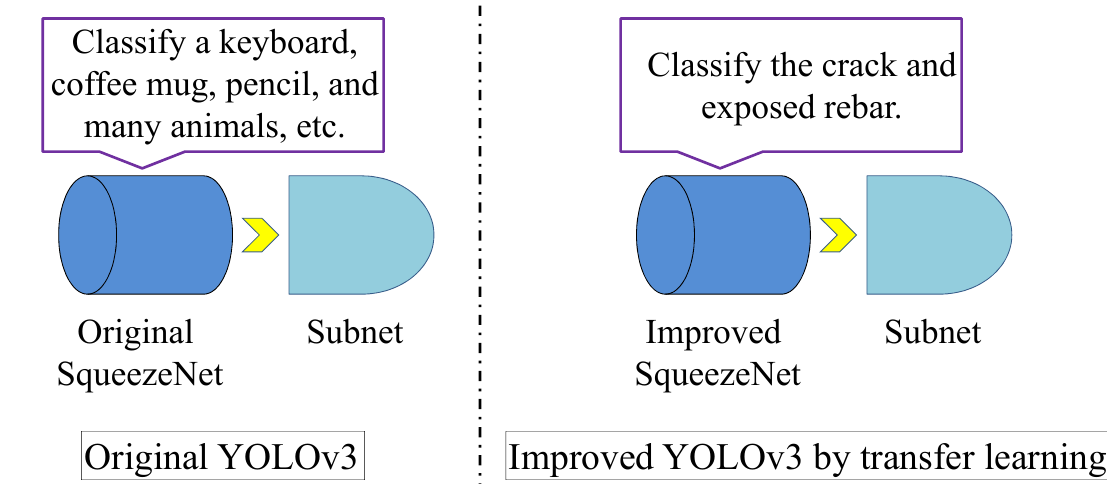
Figure 6. Transfer learning for feature extractor of the YOLOv3. Data augmentation technology was used to improve the training effect by randomly transforming the raw data during the training process. The following augmentations were applied to the training sample: (1) color jitter augmentation (Figure 7b); (2) random hori- zontal flip (Figure 7c) and (3) random scaling by 10 percent (Figure 7d). Data augmentation was implemented during the training process; each epoch of the network was randomly transformed by data augmentation technology, which improved the robustness of the network. This meant that the network would have better performance.